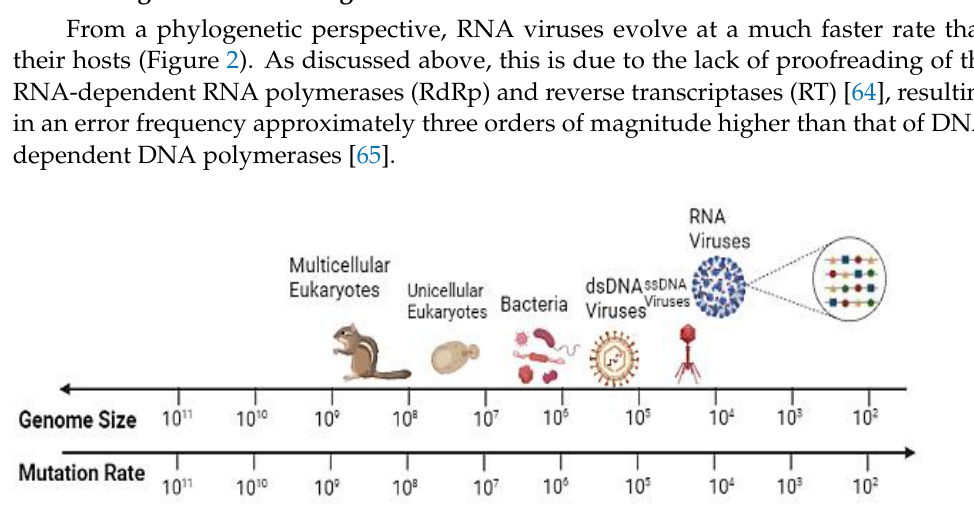
Figure 2. Biological mutation rate compared with genome size. RNA viruses have higher mutation rates. Adaptive mutations are highlighted by colored symbols, illustrating the genetic variation present in the RNA virus quasispecies. Data are adapted from